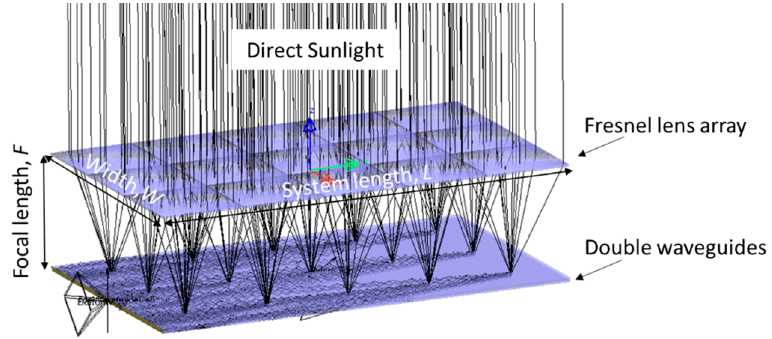
Figure 2. Physical layout of spectral splitting CPV system using double flat waveguides.